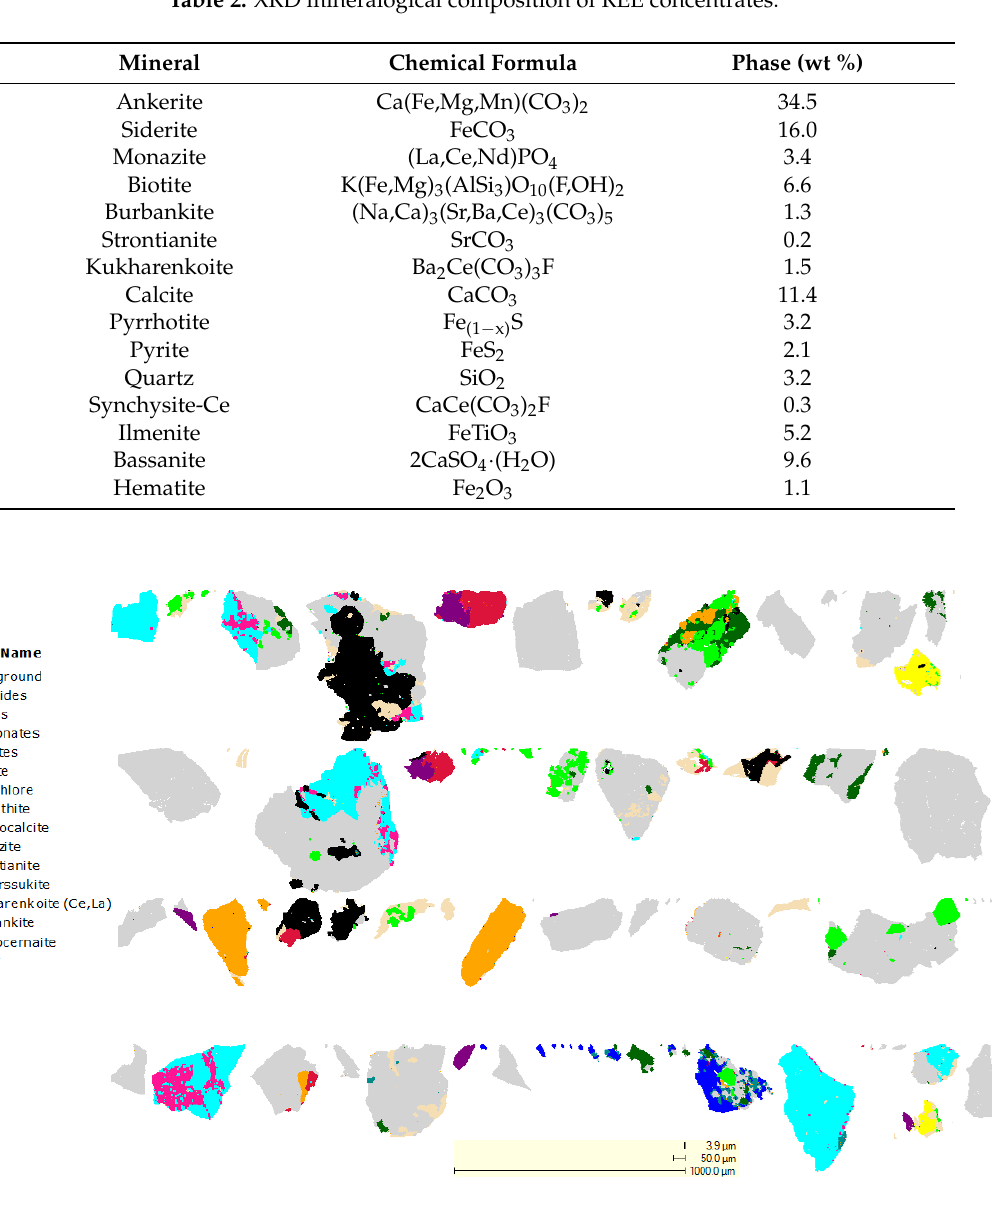
Table 2. XRD mineralogical composition of REE concentrates.